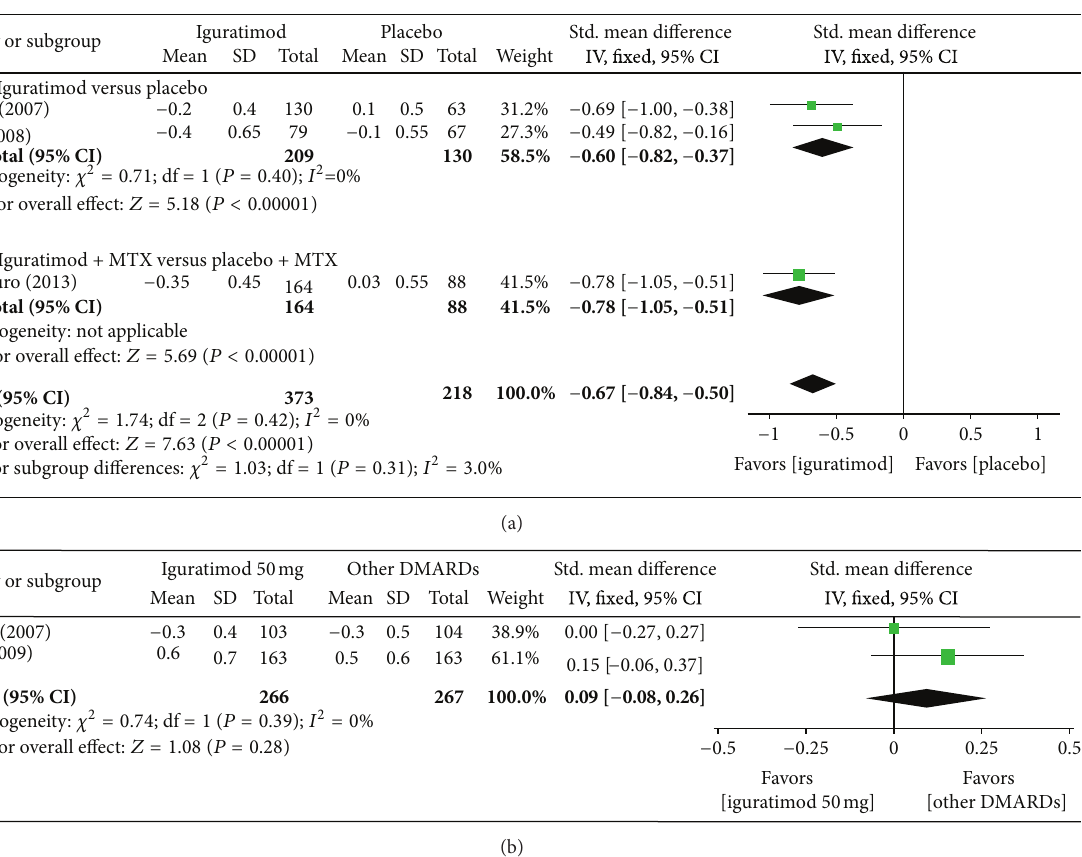
Figure 10: (a) Comparison of HAQ score between iguratimod and placebo groups. (b) Comparison of HAQ score between iguratimod and other DMARDs (MTX and SASP)